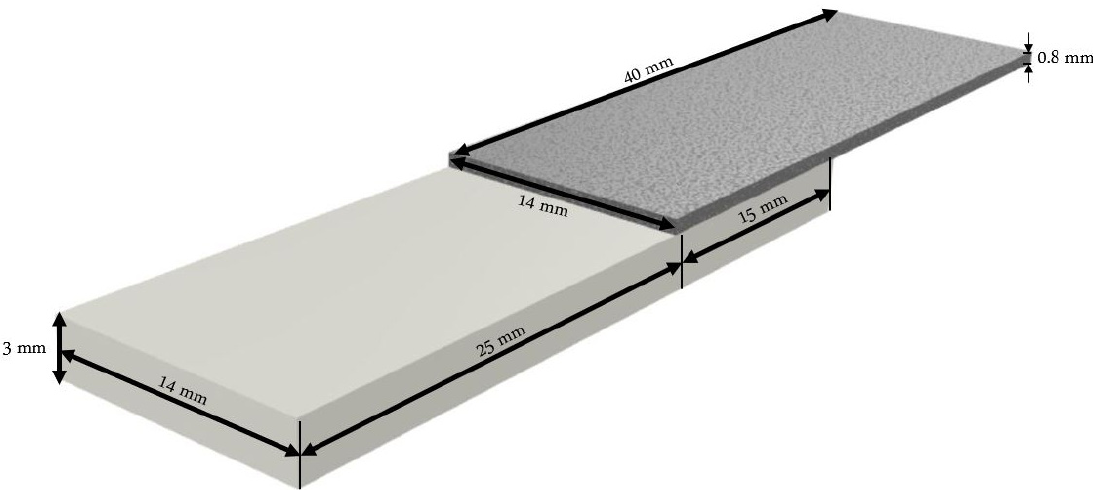
Figure 1. Lap-joint configuration: specimen geometry and dimensions. Thicker specimen represents PMMA, while the thinner one is steel.